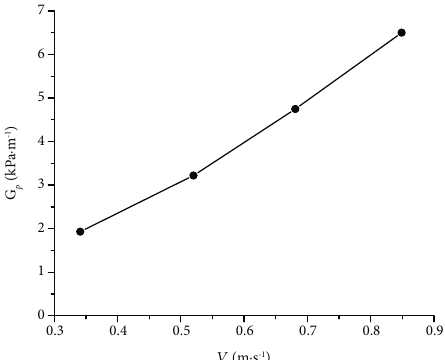
Figure 9: Average pressure-time curve at the inlet of the fracture.